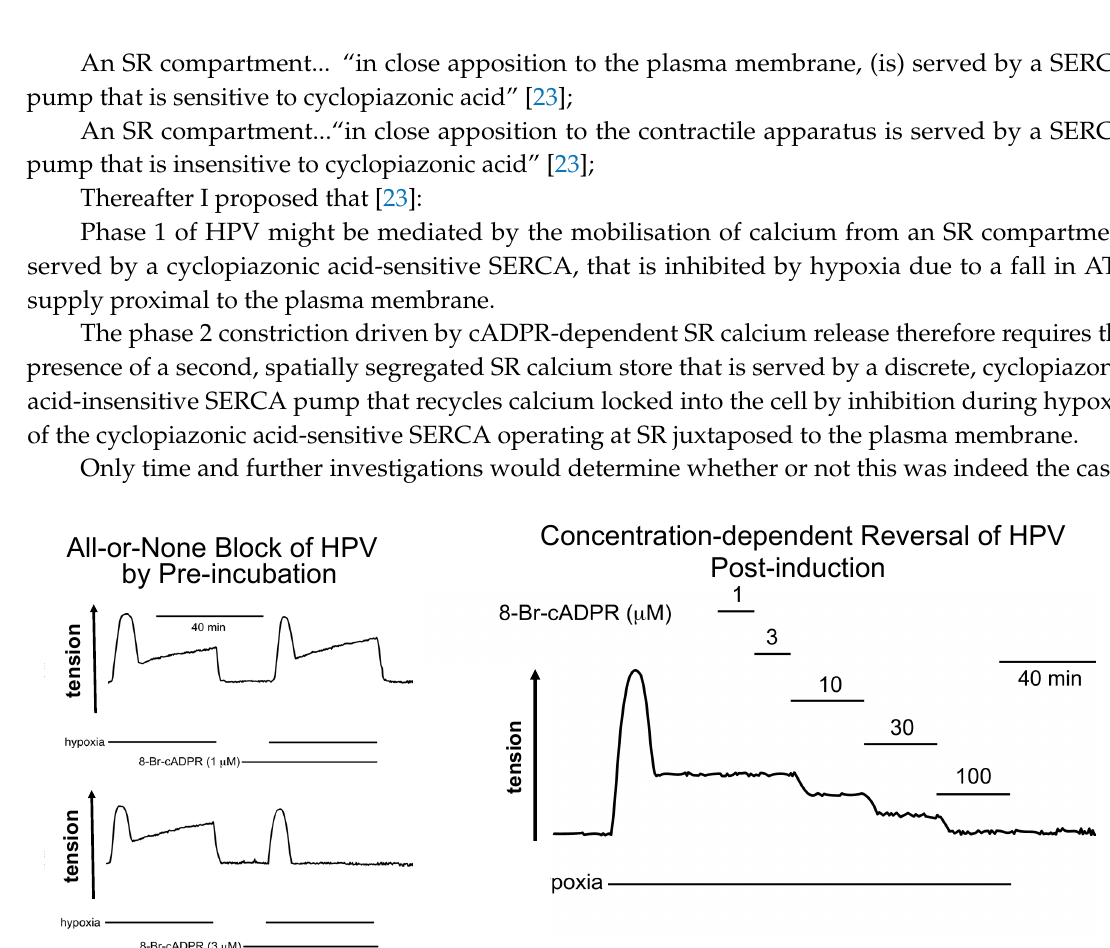
Figure 5. Pre-incubation of pulmonary artery rings with 8-bromo-cADPR blocks hypoxic pulmonary vasoconstriction (HPV) in an all-or-none manner ( left hand panels). By contrast, when applied after prior induction of HPV in pulmonary arteries without endothelium, 8-bromo-cADPR reverses HPV in a concentration-dependent manner ( right hand panel).